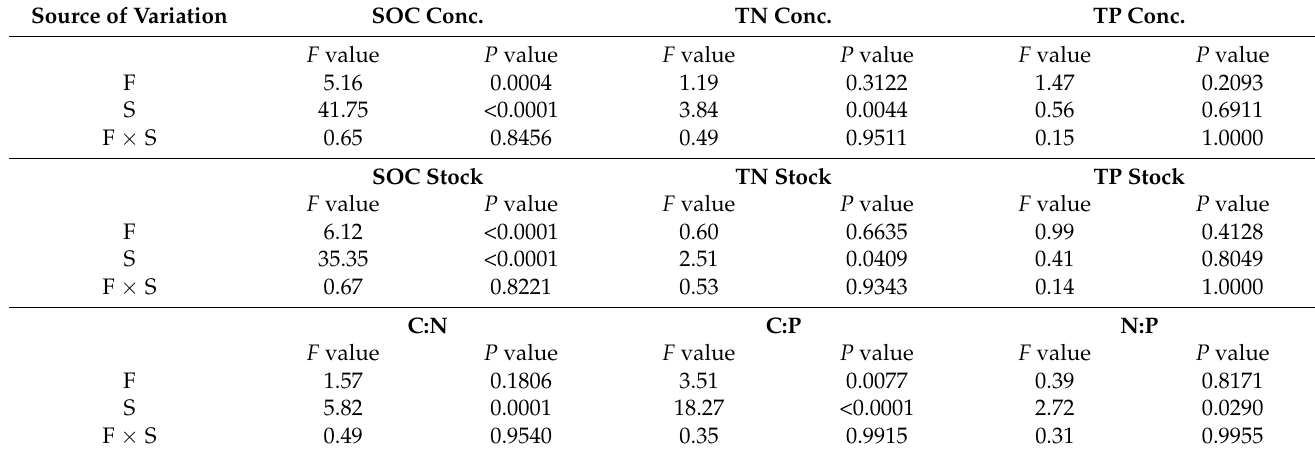
Table 1. Analysis of variance (ANOVA) of forest type (F), soil depth (S), and their interaction (F × S) on concentration (conc.), stock, and ratios of soil organic carbon (SOC), total nitrogen (TN), and total phosphorus (TP) in Udults soils among a secondary forest and Eucalypt ( Eucalyptus obliqua L’H é r.), Litchi ( Litchi chinensis Sonn., 1782), Masson pine ( Pinus massoniana Lamb.), and Slash pine ( Pinus elliottii Engelm.) plantations at Yunfu, Guangdong, China. Source of Variation SOC Conc. TN Conc. TP Conc. F value P value F